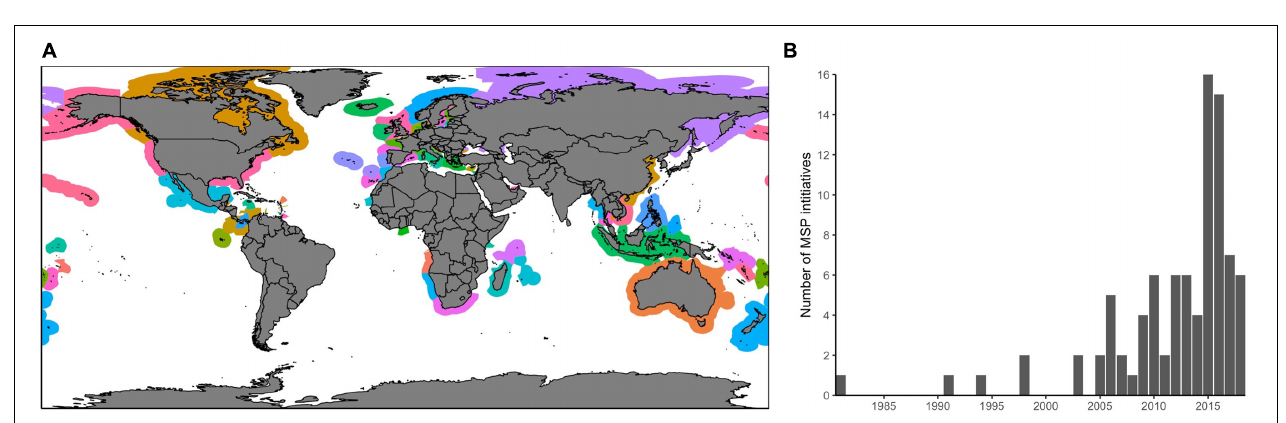
FIGURE 2 | (A) Map of countries exclusive economic zones (color) that have implemented MSP initiatives. Note that MSP does not cover the entire extent of EEZs shown. (B) Number of MSP initiatives per year. Data from http://msp.ioc-unesco.org/, accessed October 2020. Year is considered the first year mentioned in